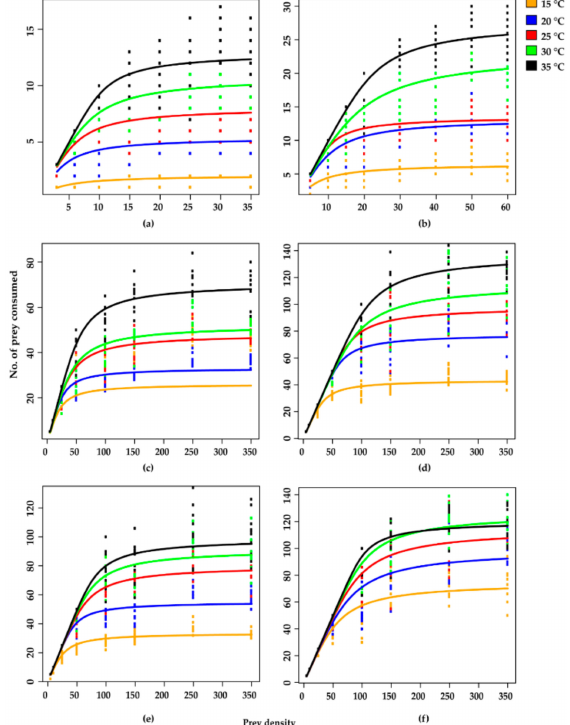
Figure 1. Type II functional response curves fitted by Roger’s random predator equation (RRPE) of di ff erent stages of Harmonia axyridis against Spodoptera litura eggs at various temperatures ( a – f ). Here, ( a ) 1st instar, ( b ) 2nd instar, ( c ) 3rd instar, ( d ) 4th instar, ( e ) adult male and ( f )